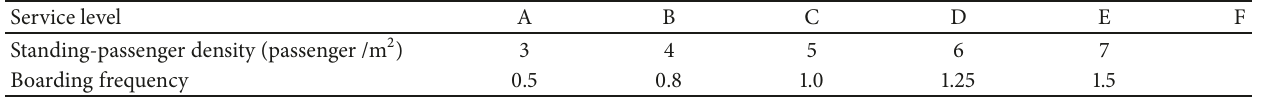
Table 4: Index of each